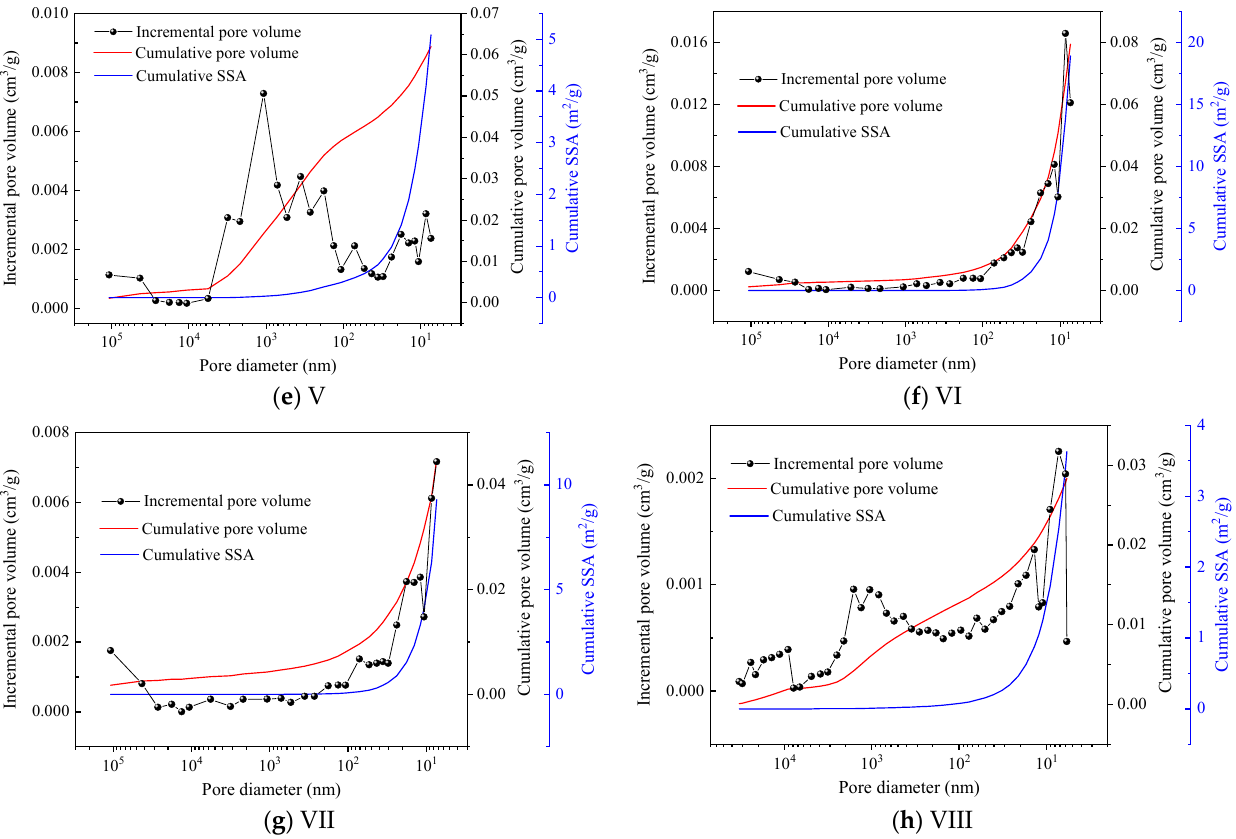
Figure 6. Pore size distribution characteristics of 8 coal samples: ( a ) Sample I; ( b ) Sample II; ( c ) Sample III; ( d ) Sample IV; ( e ) Sample V; ( f ) Sample VI; ( g ) Sample VII; ( h ) Sample VIII. Table 2. Parameters of pore structure for 8 coal samples by MIP test.